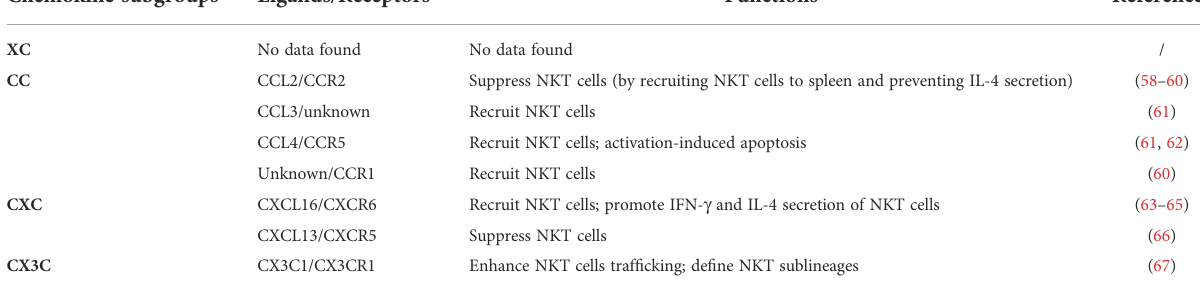
TABLE 2 Different chemokines on NKT cell activation/inactivation. Chemokine